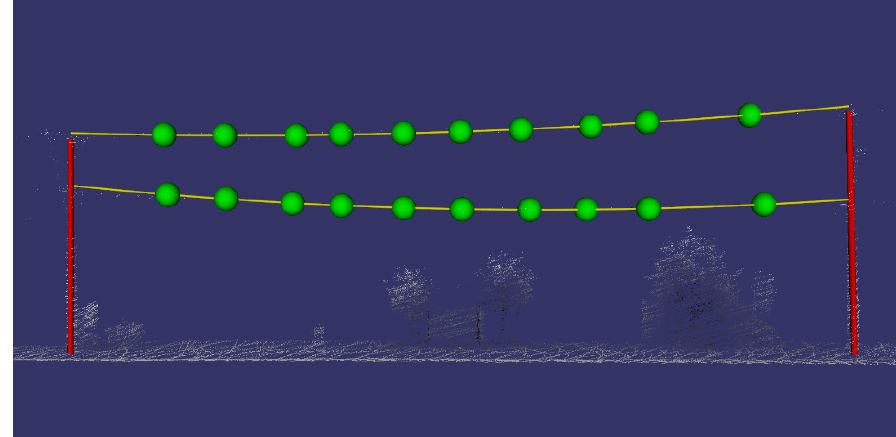
Figure 5. Example of two fitted sag models and the centre of masses used for fitting. Note the centre of mass that was part of a bush in the lower right along with the two directly above in the same window are no longer present when compared with Figure